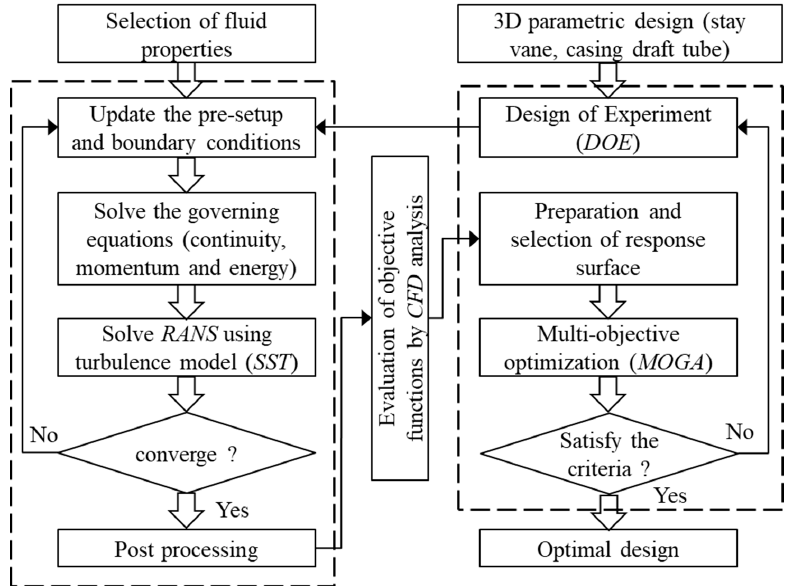
Figure 11. Numerical scheme of CFD analysis in combination with optimal design process (RANS is Reynolds-averaged Navier-Stokes).